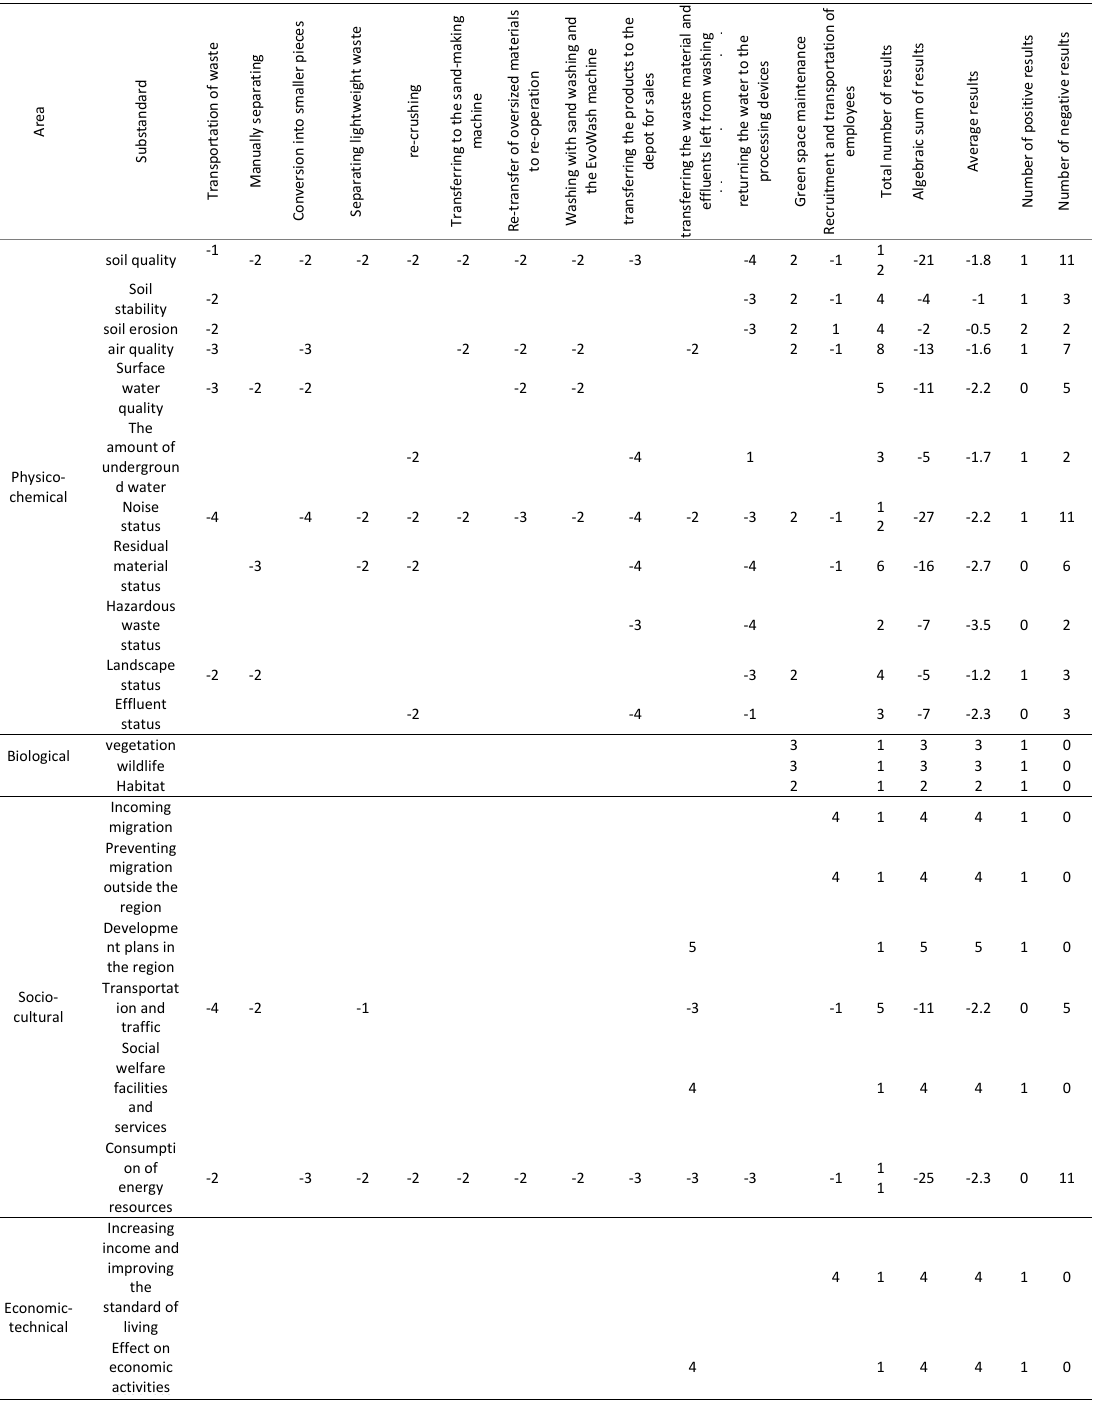
Table 4: Ranking of environmental indicators of project implementation, exploitation phase